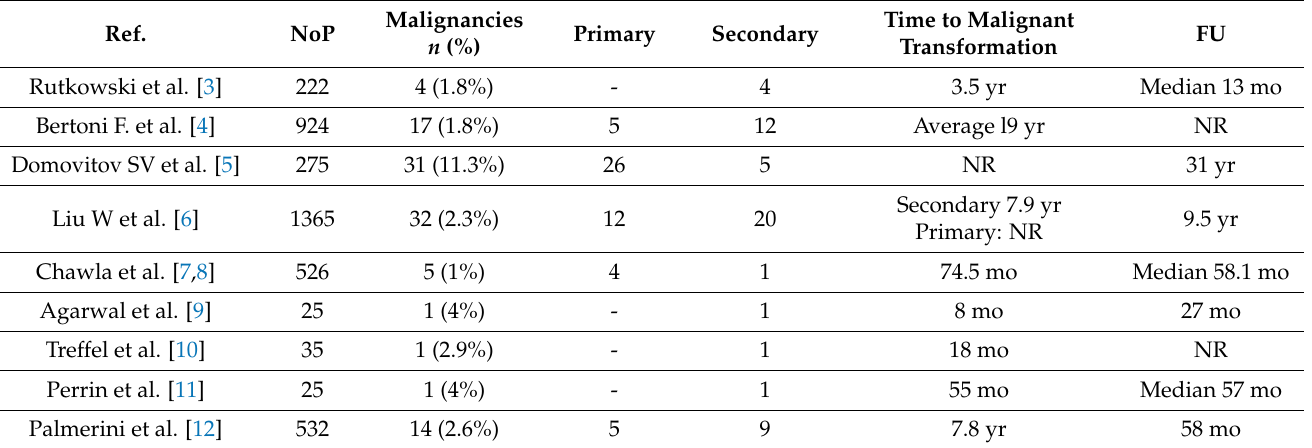
Table 1. Summary of published studies reporting malignant transformation after histological diagno- sis of